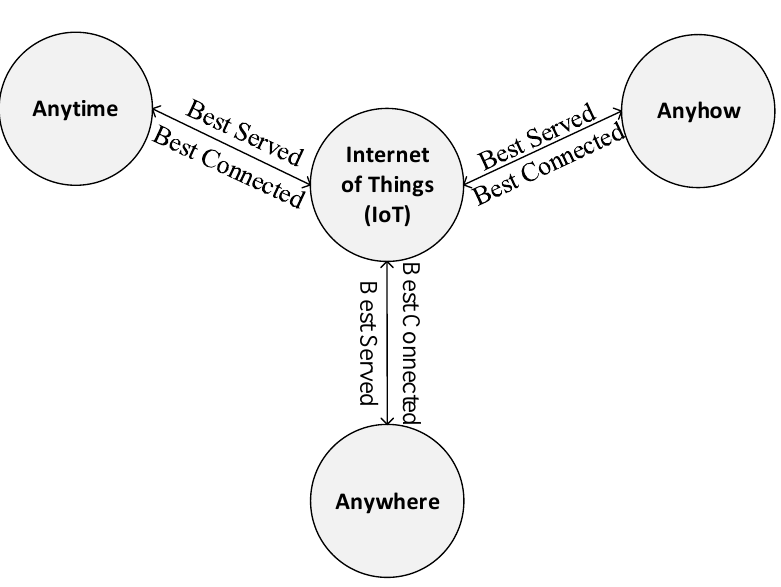
Internet of Things